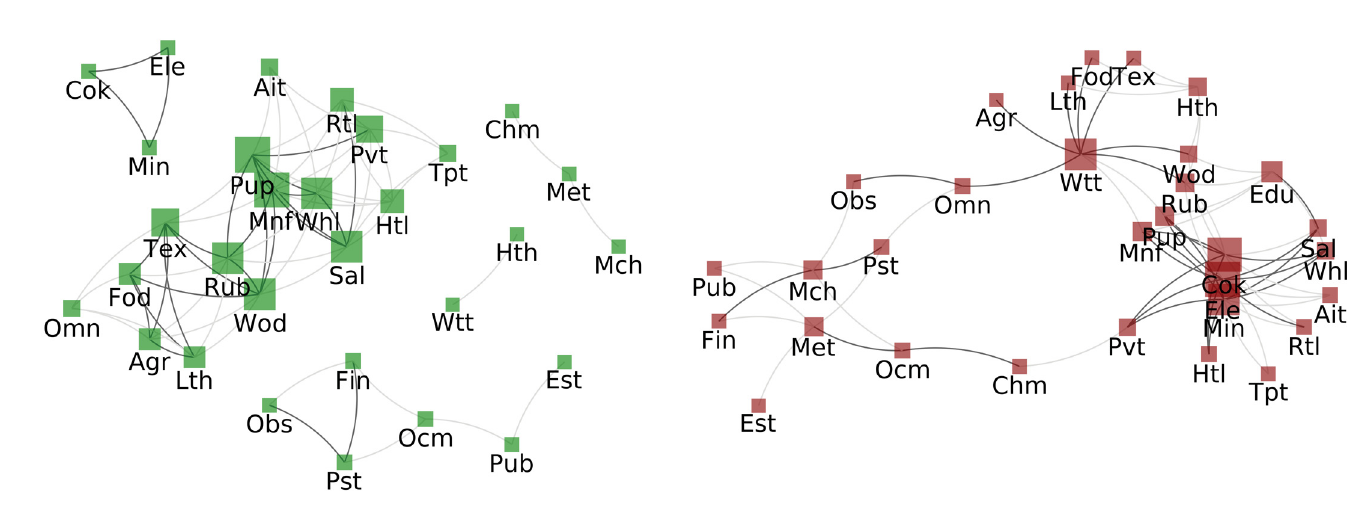
Fig 8. Correlation of Sectors’ Normalised Strength. Left: Correlatedsectors - sectors are connectedwith a dark grey link if the Pearson coefficient ¼ 0 : 91 if the coefficient is only above T þ ¼ 0 : 82 the link is light grey. Right: Anticorrelated sectors - Two betweentheir strengths time series is above T þ 1 0 ¼ (cid:0) 0 : 89 if the coefficient is only below T (cid:0) ¼ (cid:0) 0 : 80 the sectors are connectedin dark grey if their strengths time series have a Pearson coefficient below T (cid:0) 1 0 link is light grey. In both the size of of the nodes is proportional to the strength of the node (regardinglight